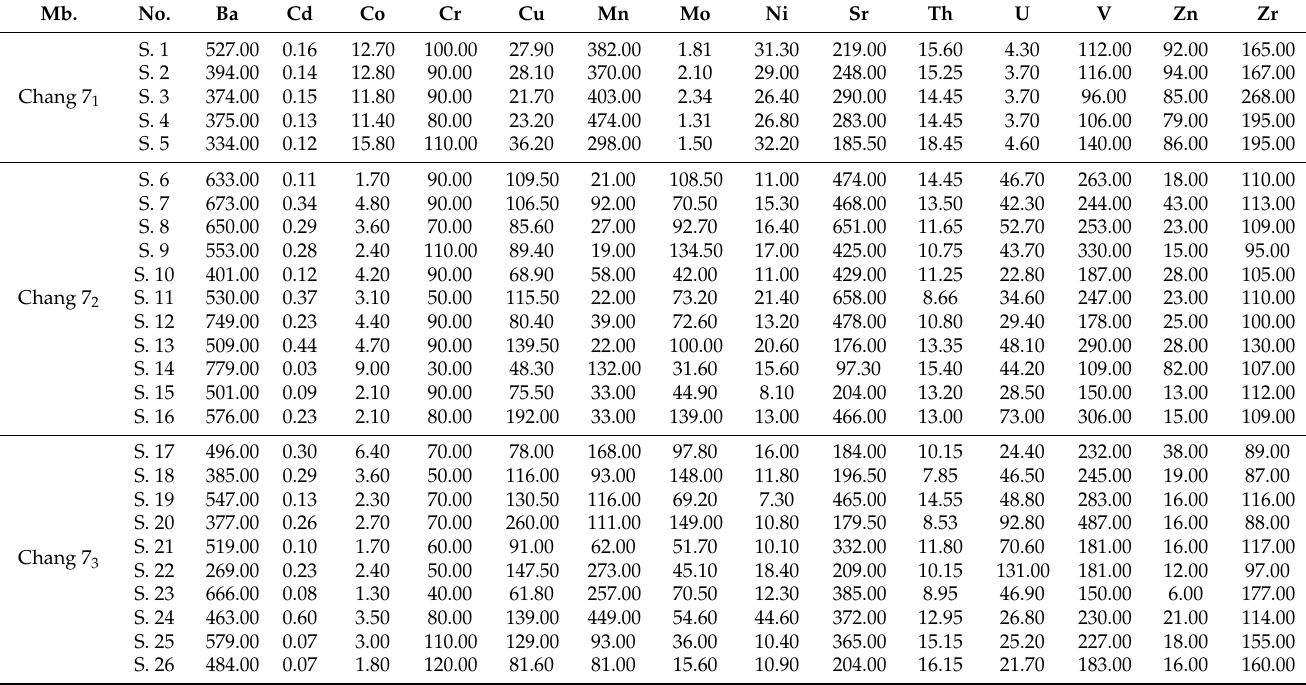
Table 2. Trace element contents (ppm) of the Chang 7